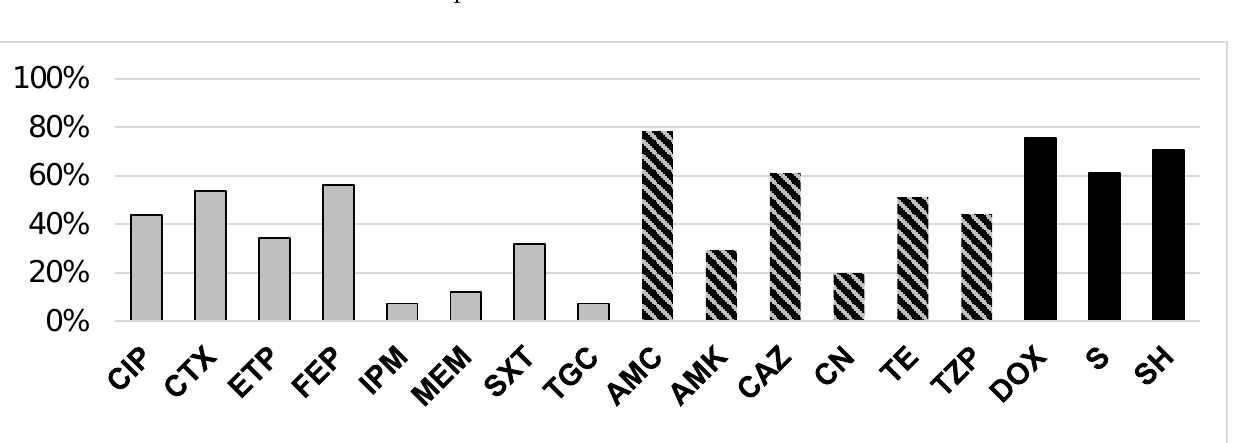
Figure 2. The antibiotic resistance of the tested cephalosporine-resistant strains isolated from meat samples ( n = 41). All the strains were resistant to ampicillin (AMP) and cefuroxime (CXM); thus, these antibiotics were excluded from the graph. In black: antibiotics used only in veterinary thera- pies; in grey: antibiotics used only in human therapies; black-grey stripes: antibiotics used both in veterinary and human therapies; AMC — amoxicillin/clavulanic acid; TZP — piperacillin/tazobactam; CTX — cefotaxime; CAZ — ceftazidime; FEP — cefepime; IPM — imipenem; MEM — meropenem; ETP — ertapenem; AMK — amikacin; CN — gentamycin; CIP — ciprofloxacin; SXT — co-trimoxazoles; TGC — tigecycline; TE — tetracycline; DOX — doxycycline; S — streptomycin; SH — spectinomycin .